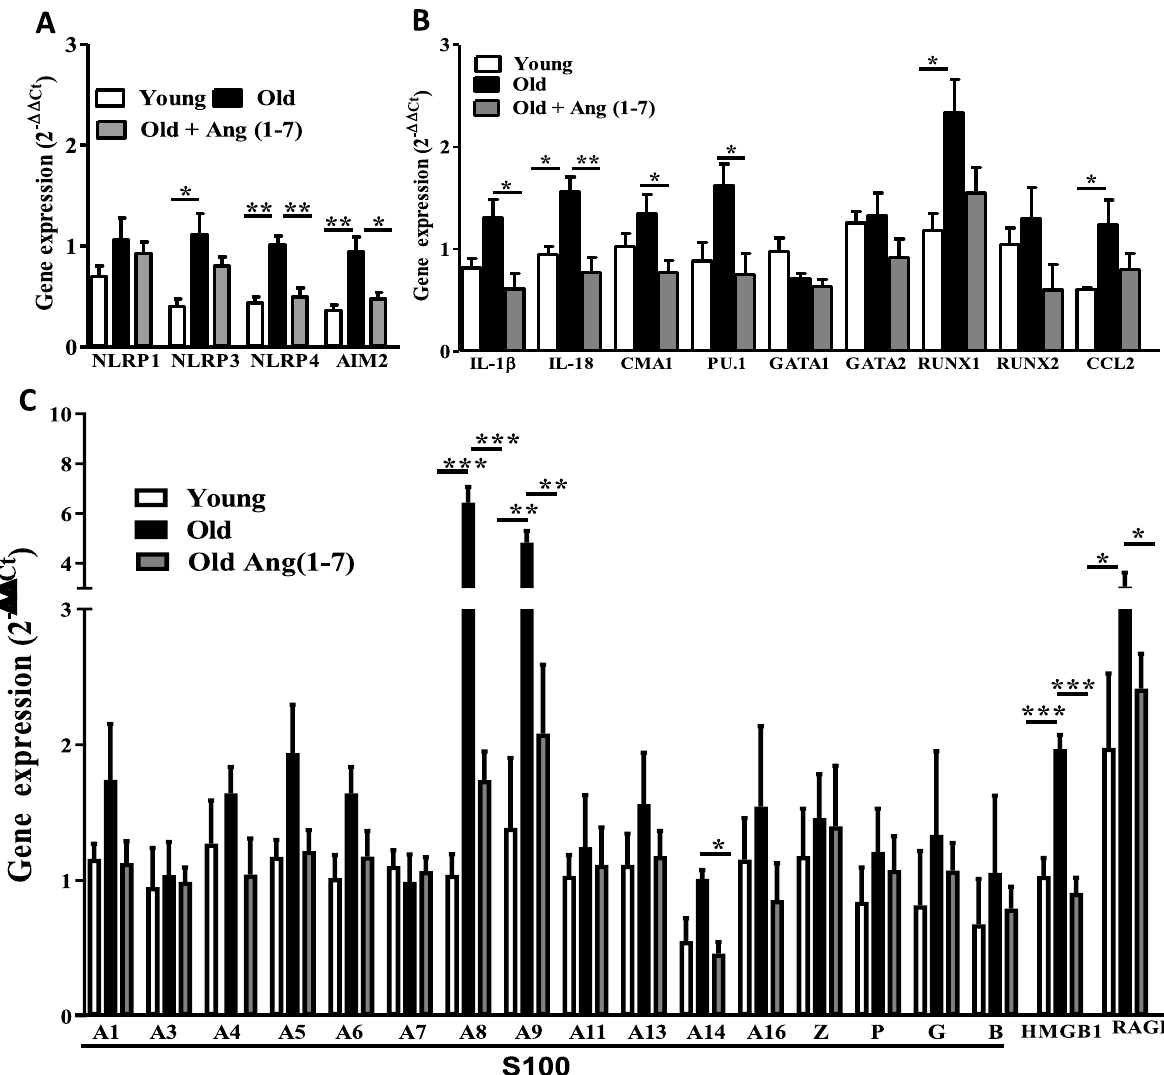
Figure 5. Expression of alarmins in the aging bone marrow cells and the effect of Ang-(1–7). ( A , B ) Gene expression of selected pro-myelopoietic and pro-inflammatory factors were altered in aging and by Ang- (1–7). *P < 0.05 and **P < 0.01, n = 5. One-way ANOVA with Tukey’s test for multiple comparisons was used to test for statistical significance. ( C ) Gene expression of alarmins. S100A8, S100A9, S100A14 and HMGB1, and the receptor RAGE were higher in the bone marrow cells of Old mice compared to the Young (*P < 0.05, **P < 0.01, ***P < 0.001, n = 5) and it was reversed by Ang-(1–7) compared to the untreated (*P < 0.05, **P < 0.01, ***P < 0.001, n = 5). Groups were compared by One-way ANOVA followed by Tukey’s post-test for multiple